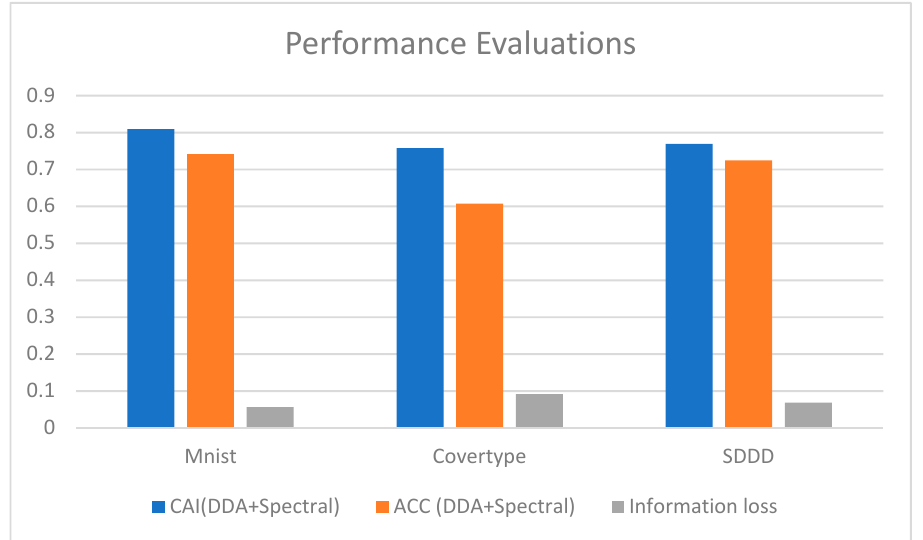
Figure 6. The performance evaluation of the proposed methods.